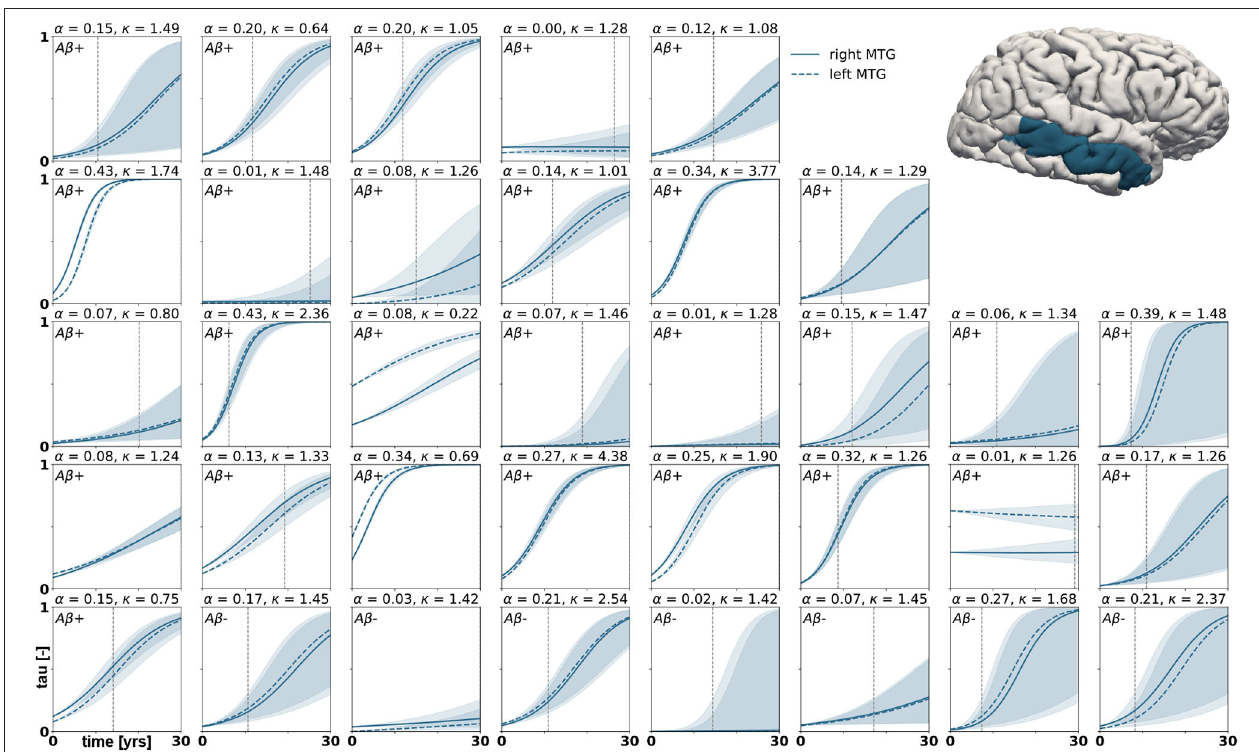
FIGURE 7 | Posterior predictive modeling. Predictions for the change in tau in the middle temporal gyrus in 30 years after first tau PET scan for 35 subjects. Shaded areas around the curves represent the 95% credible intervals of the